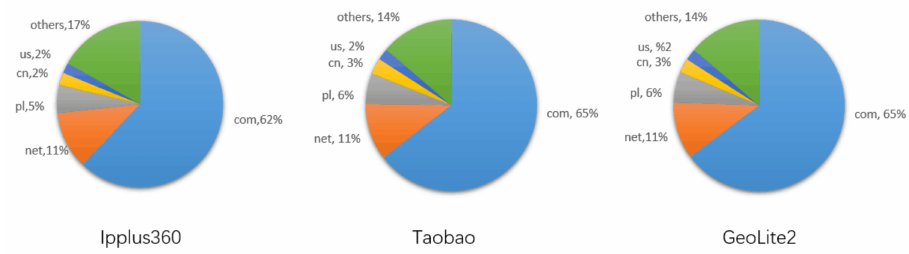
Figure 9. Top 5 top-level domains (TLD) of China overseas server dependency domain (OSD).